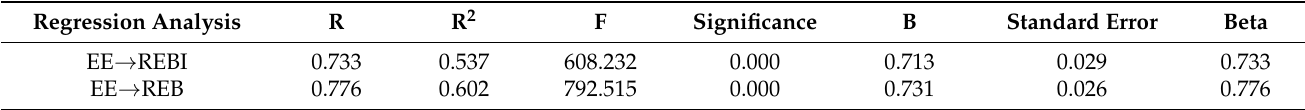
Table 10. Situational environmental education moderator variable analysis